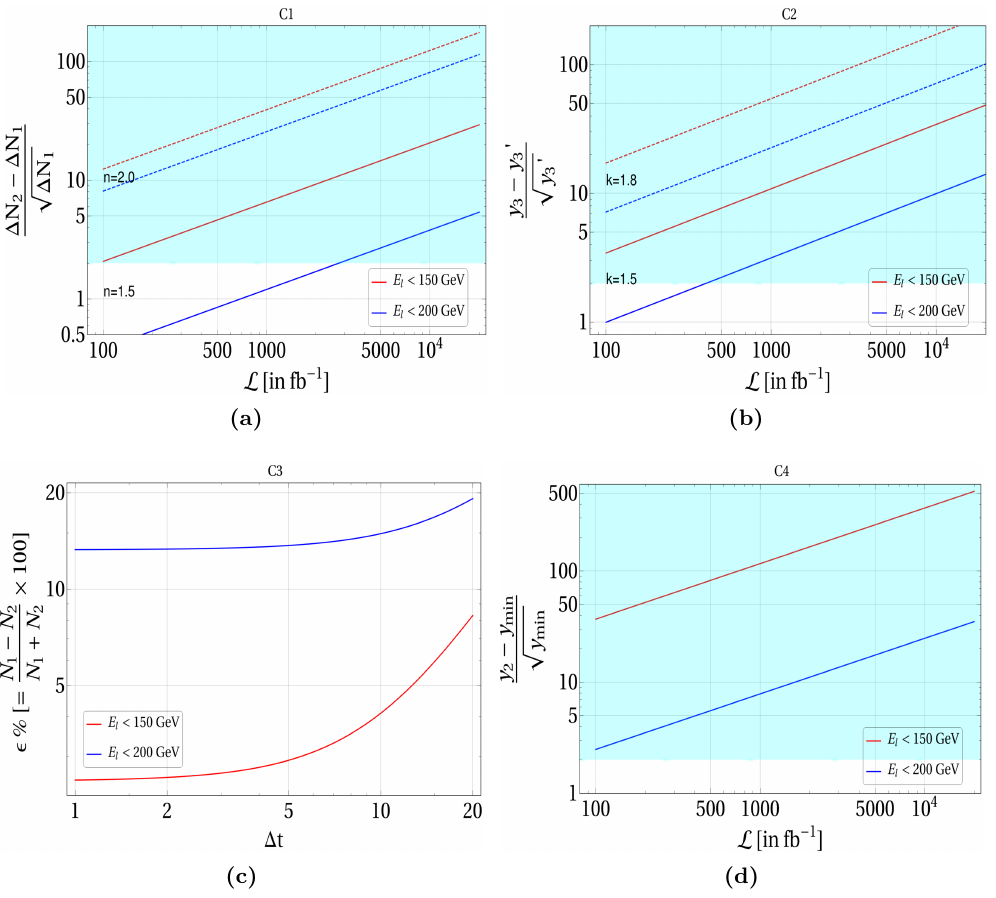
Figure 24. Validation of C1, C2, C3, C4 conditions for BP1 with two specified lepton energy cuts ( E 150 GeV, E 200 GeV): (a) R as a function of L for different n values, (b) R ‘ 1 < ‘ 1 < C 1 function of L for different k values, (c) R as function of ∆ t and (d) R C 3